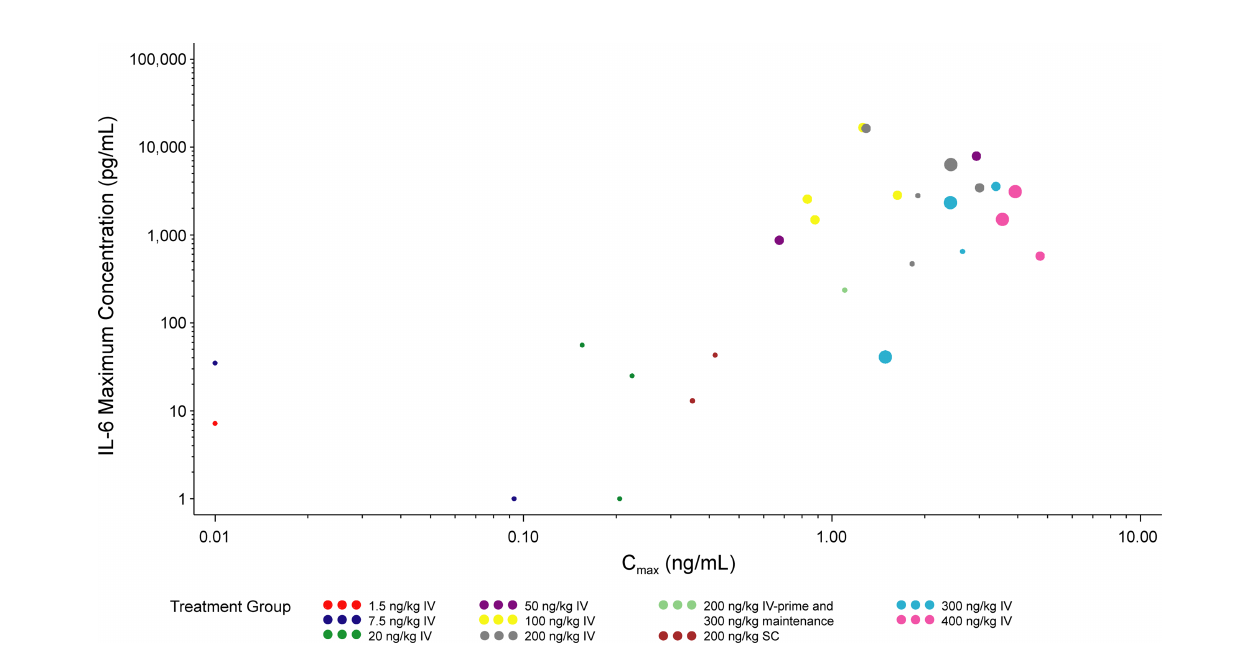
FIGURE 4 | Maximum IL-6 concentration vs C max (cycle 1). The LLOQ values were set to 0.01 ng/mL for C max and 1 pg/mL for IL-6. Values >7900 for IL-6 were set to 7900 pg/mL. The size of the circles re fl ect the grade of CRS observed. Time frame for maximum IL-6 level, C max , and maximum CRS grade are both the fi rst dosing interval during cycle 1 (time 0 hr to 168 hr after cycle 1 day 1 dose). C max , maximum serum concentration; CRS, cytokine release syndrome; IL, interleukin; IV, intravenous; SC,